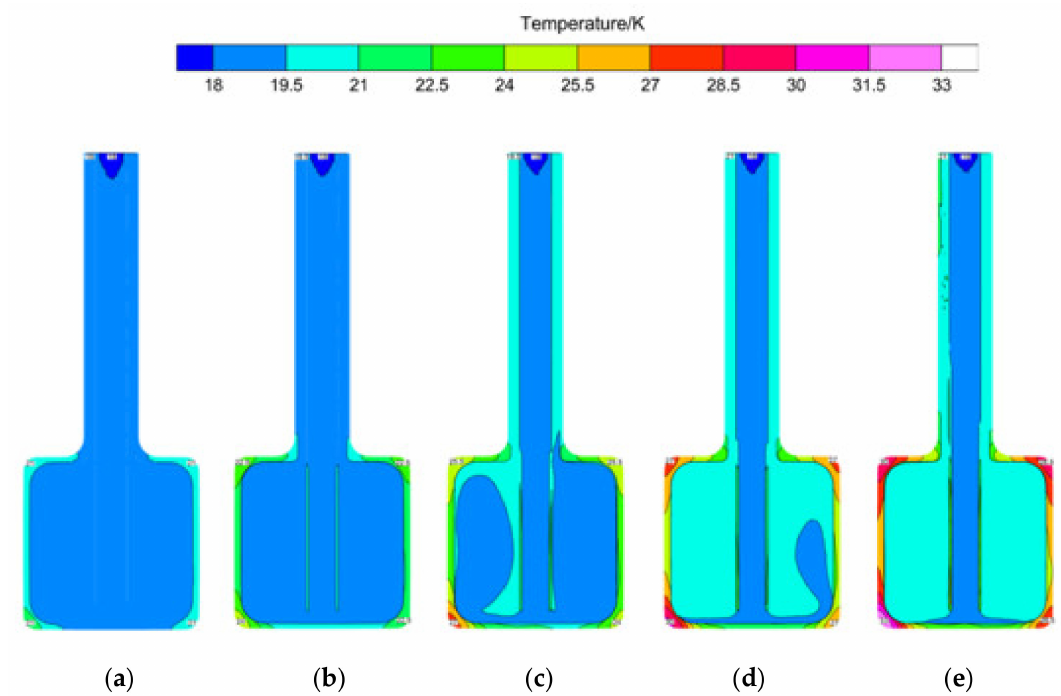
Figure 7. The temperature distribution of DPHM with various beam power ( q = 60 g/s, x = 0 mm): ( a ) 100 kW; ( b ) 200 kW; ( c ) 300 kW; ( d ) 400 kW; ( e ) 500 kW.